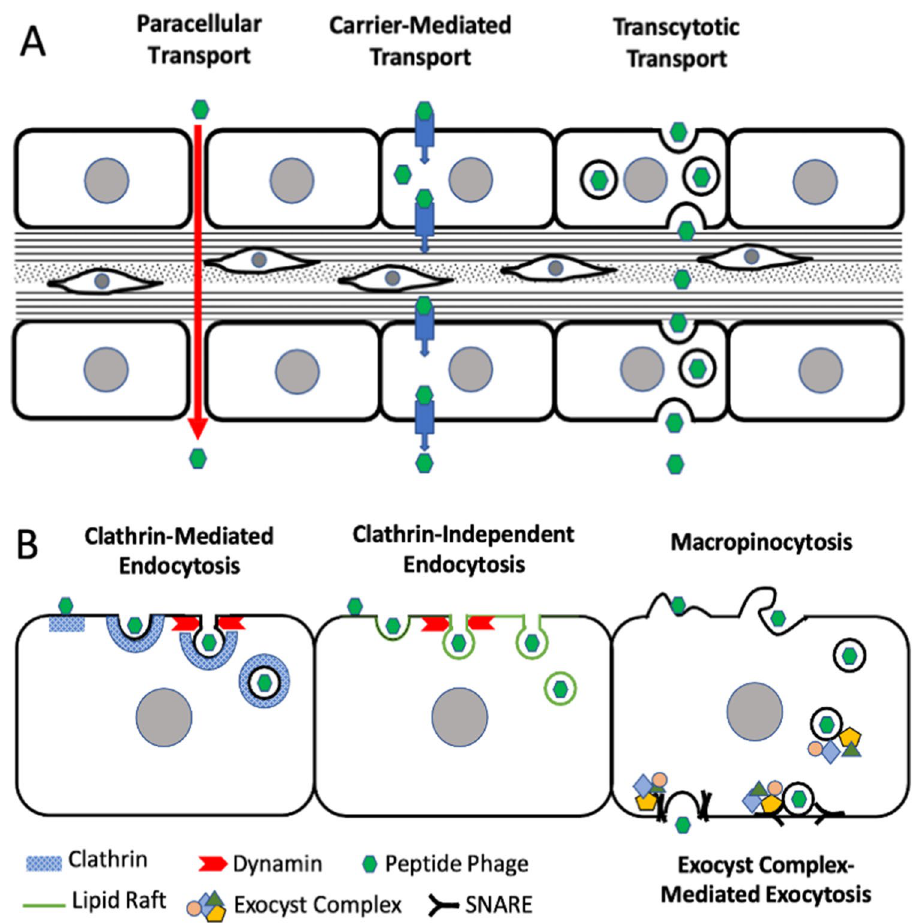
Figure 6. ( A ) Possible mechanisms of peptide phage transport across the TM. Paracellular transport is not active and unlikely since trans-TM transport is oxygen- and temperature-sensitive. Carrier-mediated transport is limited to relatively small molecules. Transcytosis can move large cargo across polarized epithelia in either direction, and was thus investigated. ( B ) Potential mechanisms involved in transcytosis. Inhibitors of clathrin or dynamin did not block trans-TM transport, ruling out clathrin-mediated endocytosis. Several forms of clathrin- independent endocytosis including caveolar and caveolin-independent endocytosis occur in cholesterol-rich lipid rafts, but cholesterol depletion did not affect trans-TM transport. Inhibition of macropinocytosis, capable of endocytosing large (> 500 nm) particles including viruses, virtually eliminated trans-TM transport, as did inhibition of exocytosis mediated by the exocyst complex, implicating participation of both processes in trans-TM